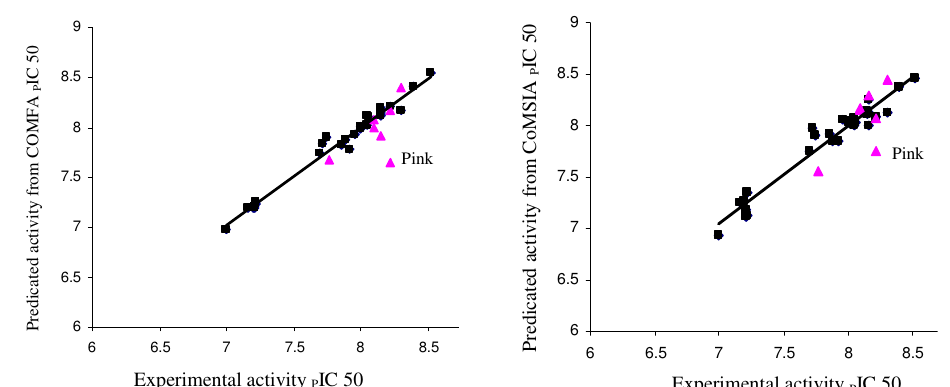
Figure 2. Plots of experimental activity vs. predicted activity from CoMFA and CoMSIA (Pink colored values represent the test set) Table 2. The statistical parameters for the CoMFA and CoMSIA models Statistical